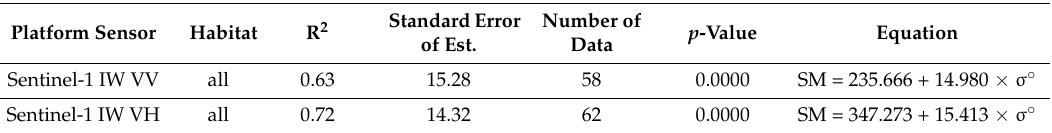
Table 5. Results of the relationships at the 95% confidence level between measured SM and calculated SM from Sentinel-1 VV and VH data.